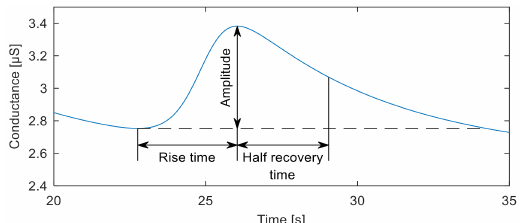
Figure 2. Event-related skin conductance responses